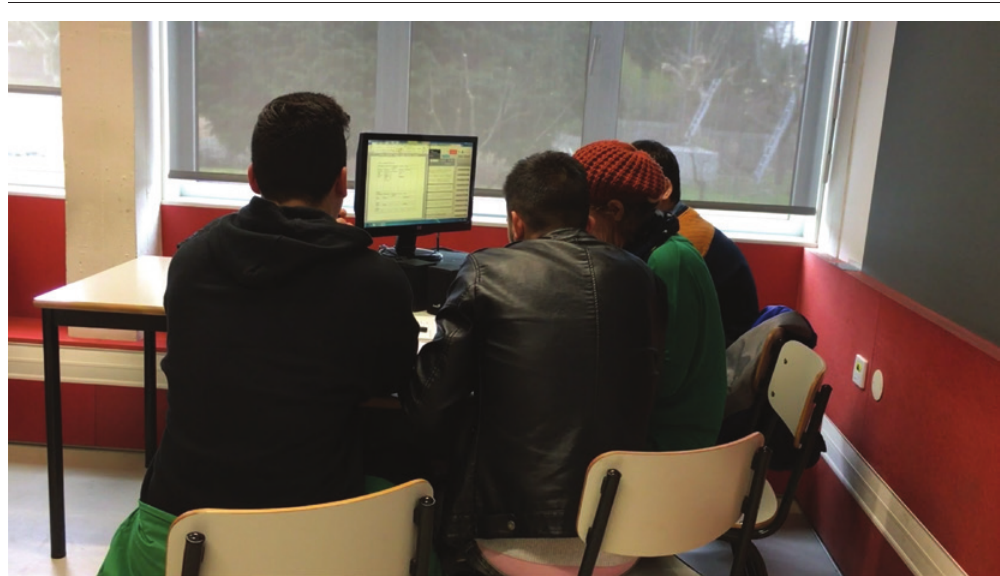
figure 2: a group of students revising their